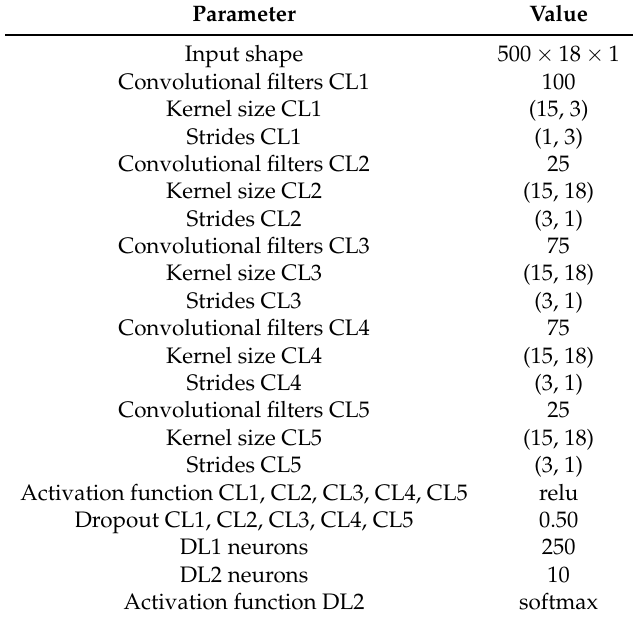
Table A1. All architecture parameters for the recognition model. CL: Convolution layer, DL: Dense